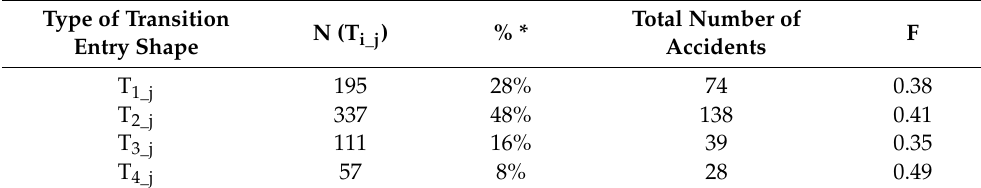
Table 2. Aggregate analysis (rural and urban areas) of data related to the transition entry shape. % * is the percentage of access points with the same type of transition entry shape compared to the total number of accesses that were noted.